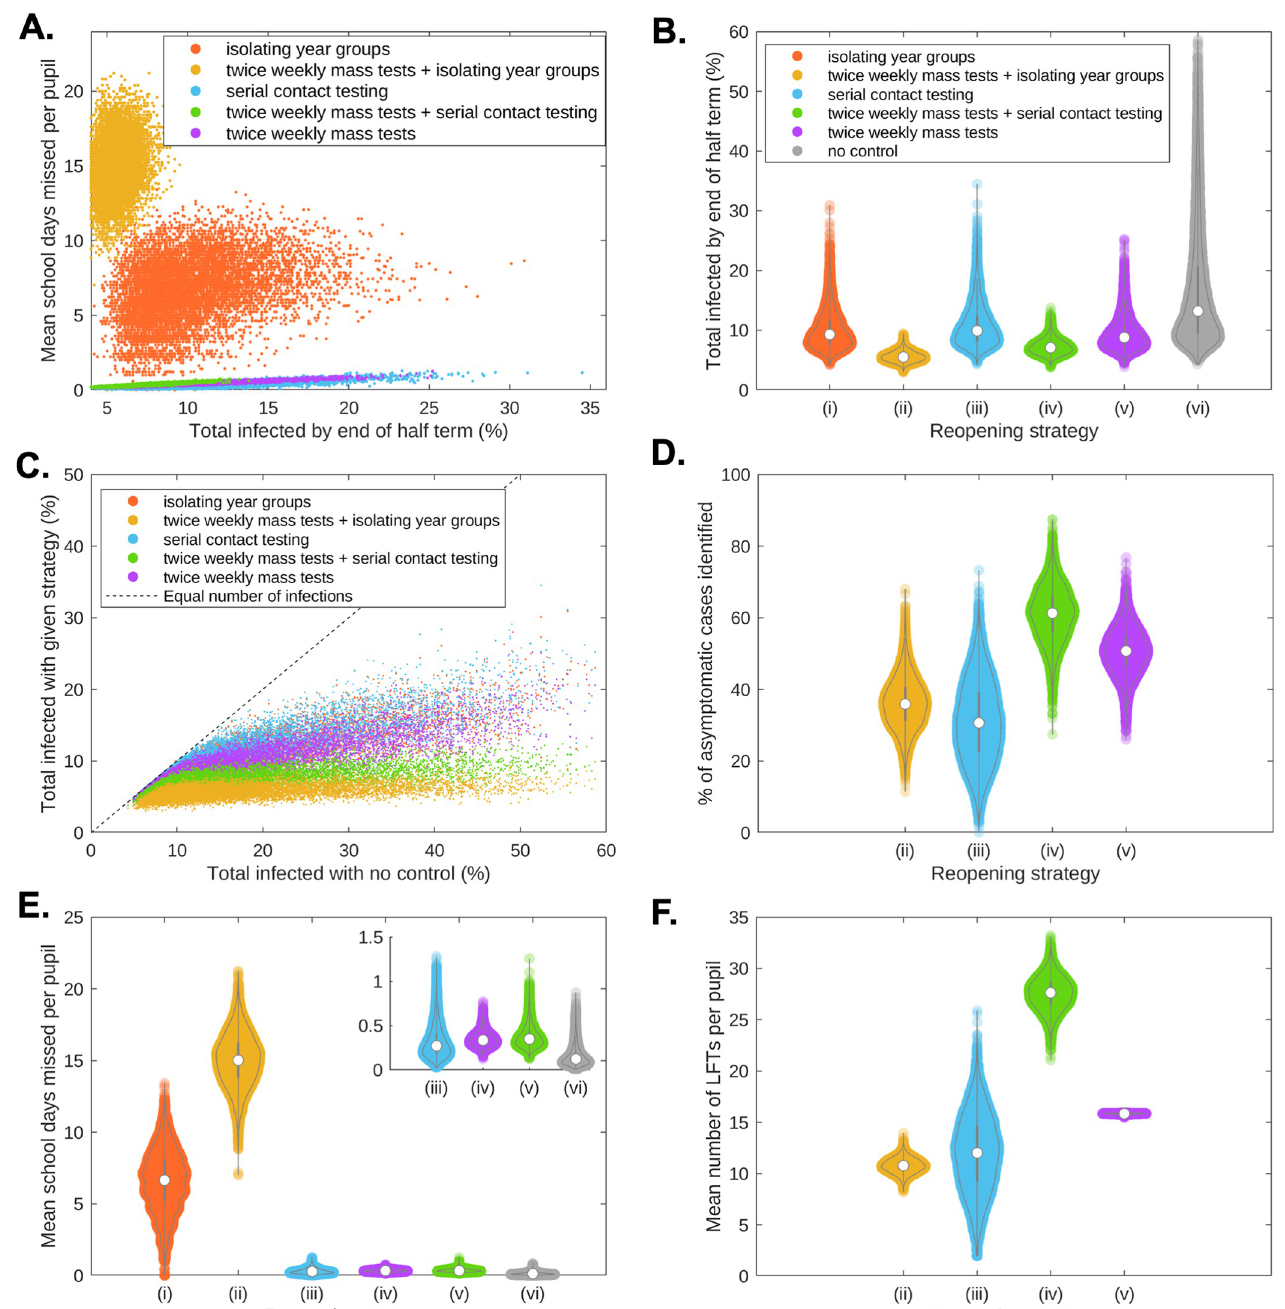
Fig 1. The trade-off between transmission, absences, and testing volume. (a) Relationship between total infections and school days missed for an isolation of year group bubbles strategy (orange), twice weekly mass testing combined with isolation of year group bubbles (yellow), serial contact testing (blue), twice weekly mass testing combined with serial contact testing (green), and twice weekly mass testing alone (purple). (b) Percentage of school pupils infected during the course of the half-term. (c) Comparison of the total number of infections by the end of the half-term by the five considered control strategies (y-axis) against the total number of infections by the end of the half-term with no infection control measures (x-axis). The dashed line corresponds to parity in the total amount of infection using no infection controls and the given control strategy. (d) For rapid testing strategies, the percentage of asymptomatic cases that had been identified through rapid testing by the end of the half term. (e) Violin plots of the mean number of school days missed per pupil within simulated schools. The inset plot shows strategies (iii)-(vi). (f) For rapid testing strategies, violin plots of the mean number of LFTs taken per pupil within simulated schools. Results produced from 10,000 simulations. In all violin plots, the circle marker denotes the median and the black bars the 50% prediction intervals.